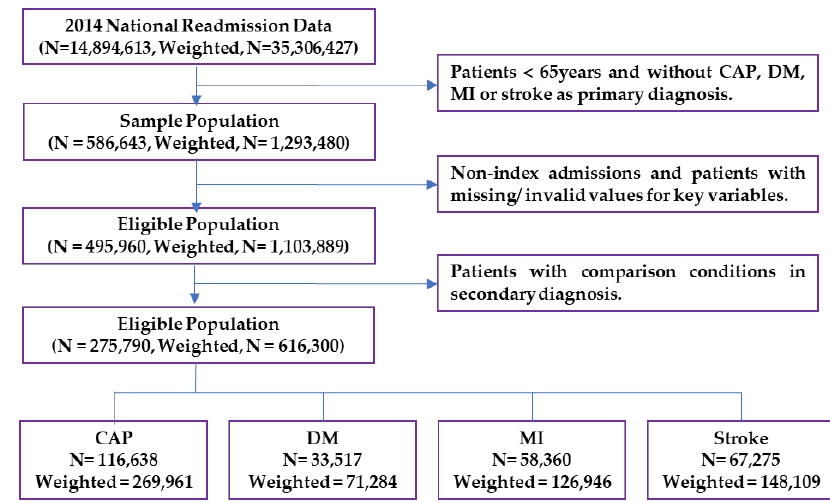
Figure 1. Sample selection flow chart.